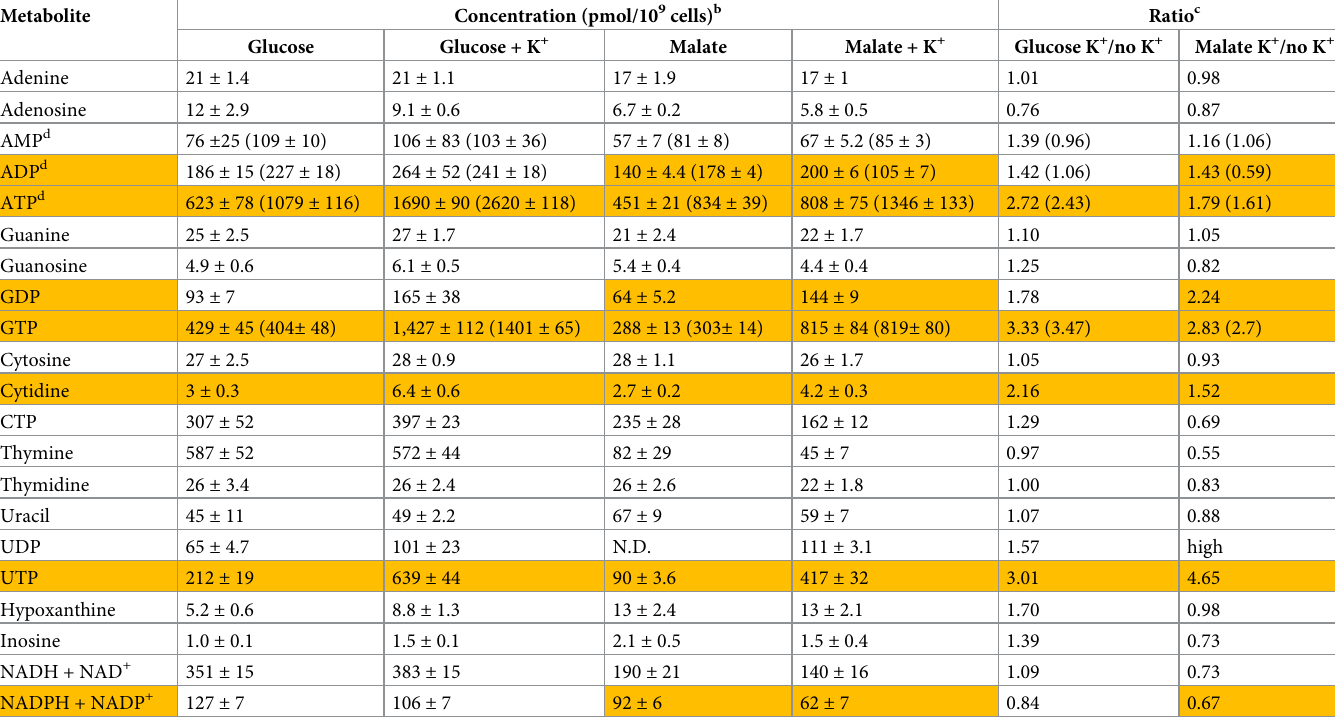
Table 8. Concentration of nitrogenated bases, nucleosides and nucleotides in wild-type cells in the absence or presence of 10 mM KCl a .